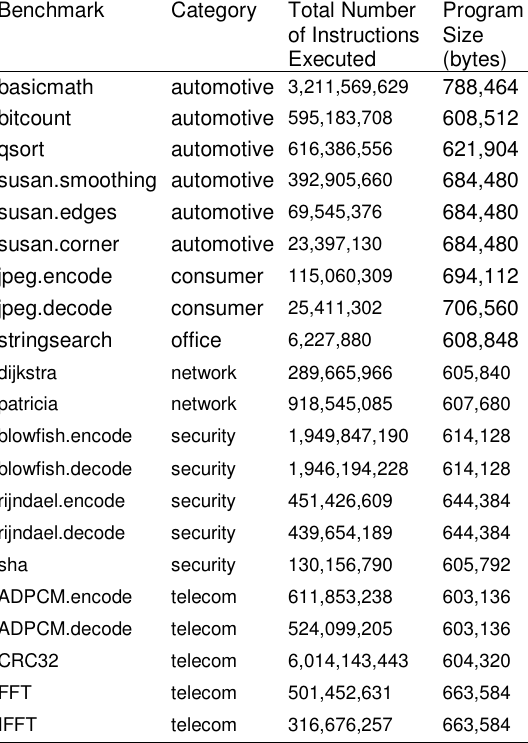
Table 2. MiBench benchmark list with